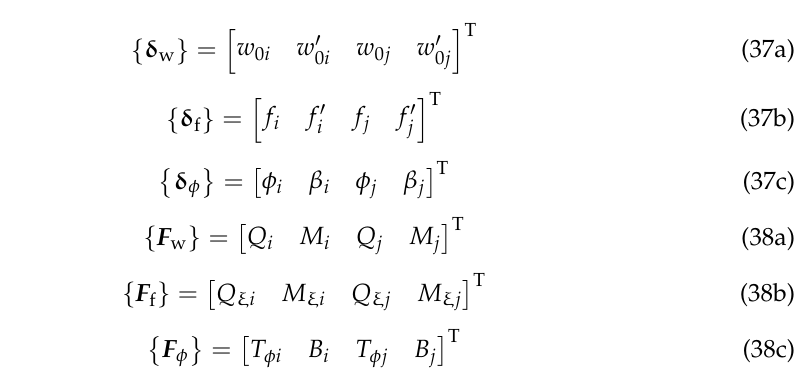
Figure 7. Beam-type finite element model.